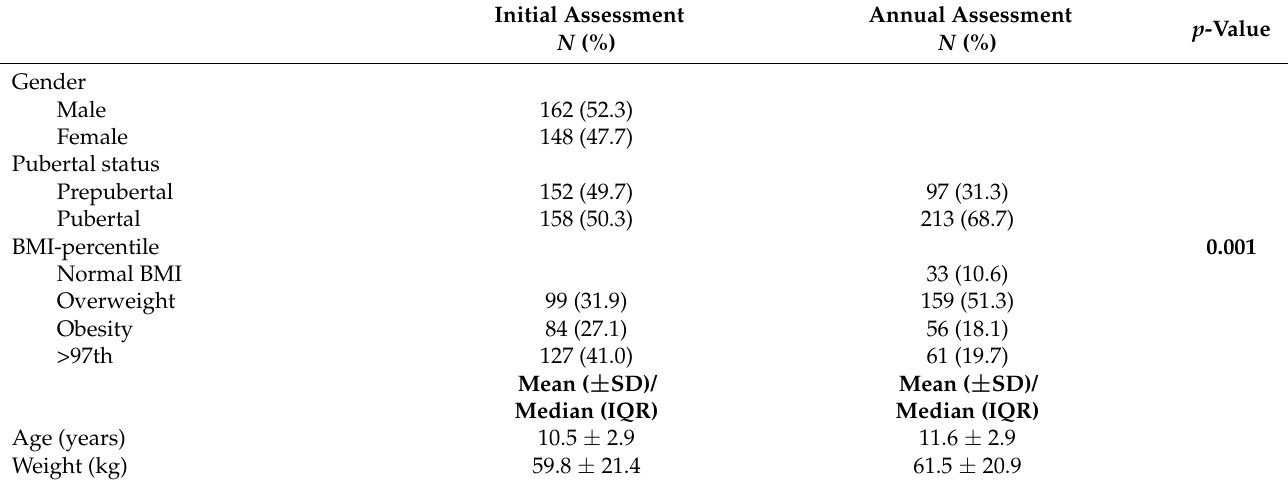
Table 2. Clinical characteristics and biochemical, endocrinologic and body composition parameters in all subjects at initial and annual